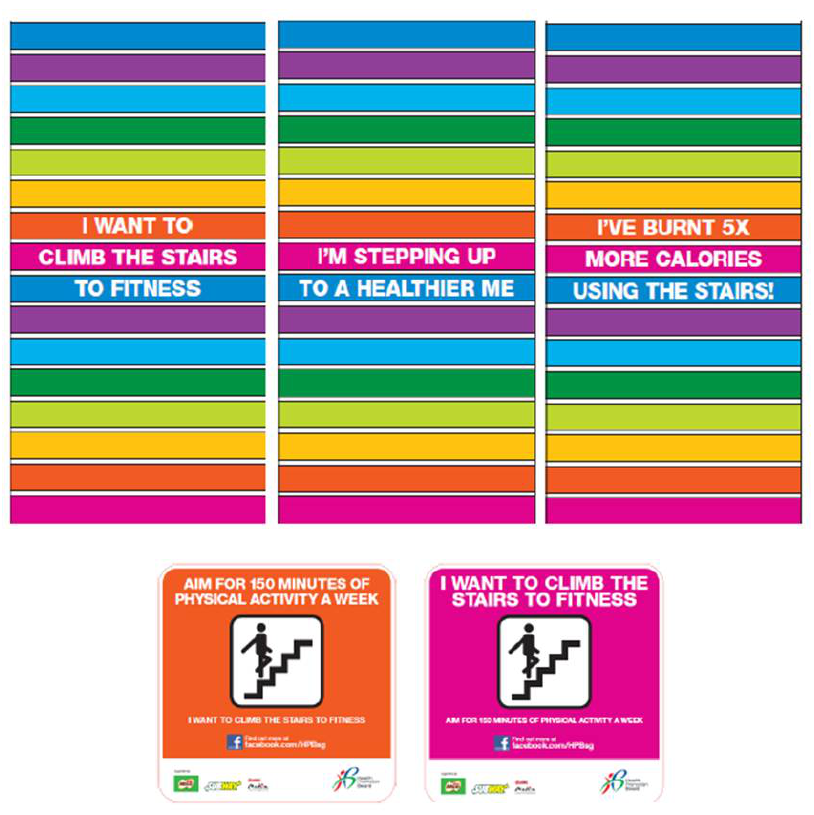
Figure 1. Design of point-of-decision prompts (PODPs) used. Stair-riser banners and floor stickers bearing physical activity messages were used as PODPs to promote the use of stairs instead of the adjacent